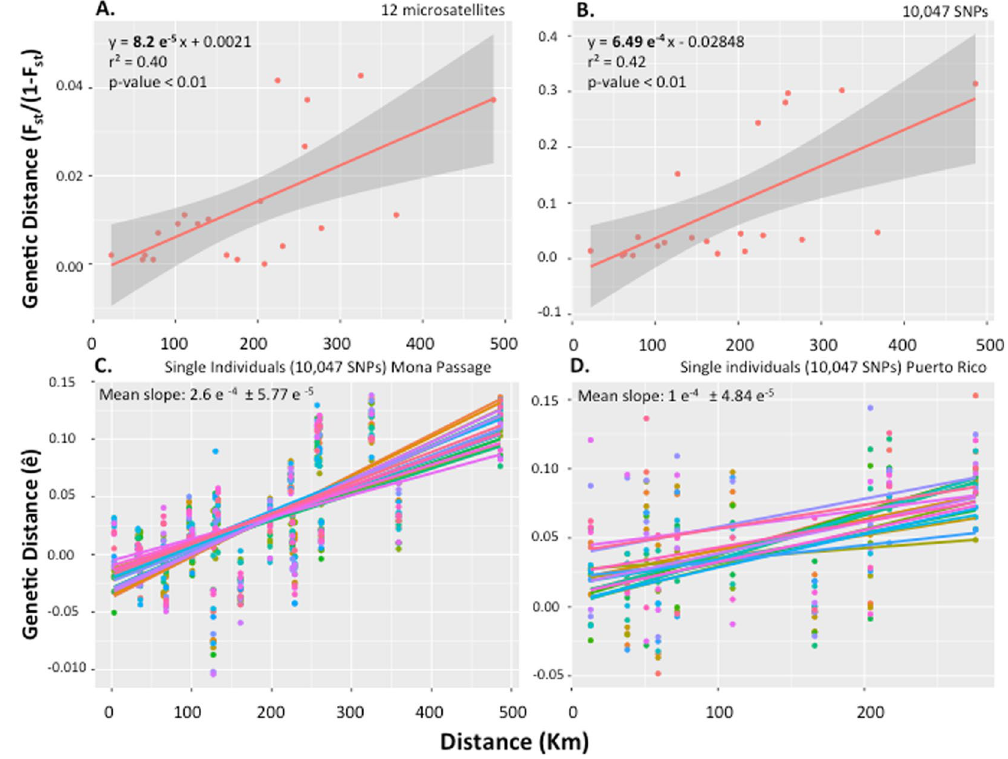
Figure 1. Isolation by Distance (IBD) in Opistognathus aurifrons from seven sampling sites along Puerto Rico MPAs (La Caleta, PNNE, Mona Island, Desecheo Island, Tres Palmas MR, La Parguera and Culebra). ( A ) IDB from 12 microsatellites; ( B ) IBD from 10,047 SNPs and ( C ) IBD from single individuals for seven sampling sites (La Caleta, PNNE, Mona Island, Desecheo Island, Tres Palmas MR, La Parguera and Culebra). ( D ) IBD from single individuals for five MPAs within Puerto Rico (Mona Island, Desecheo Island, Tres Palmas MR, La Parguera and Canal Luís Peña at Culebra) with 10,047